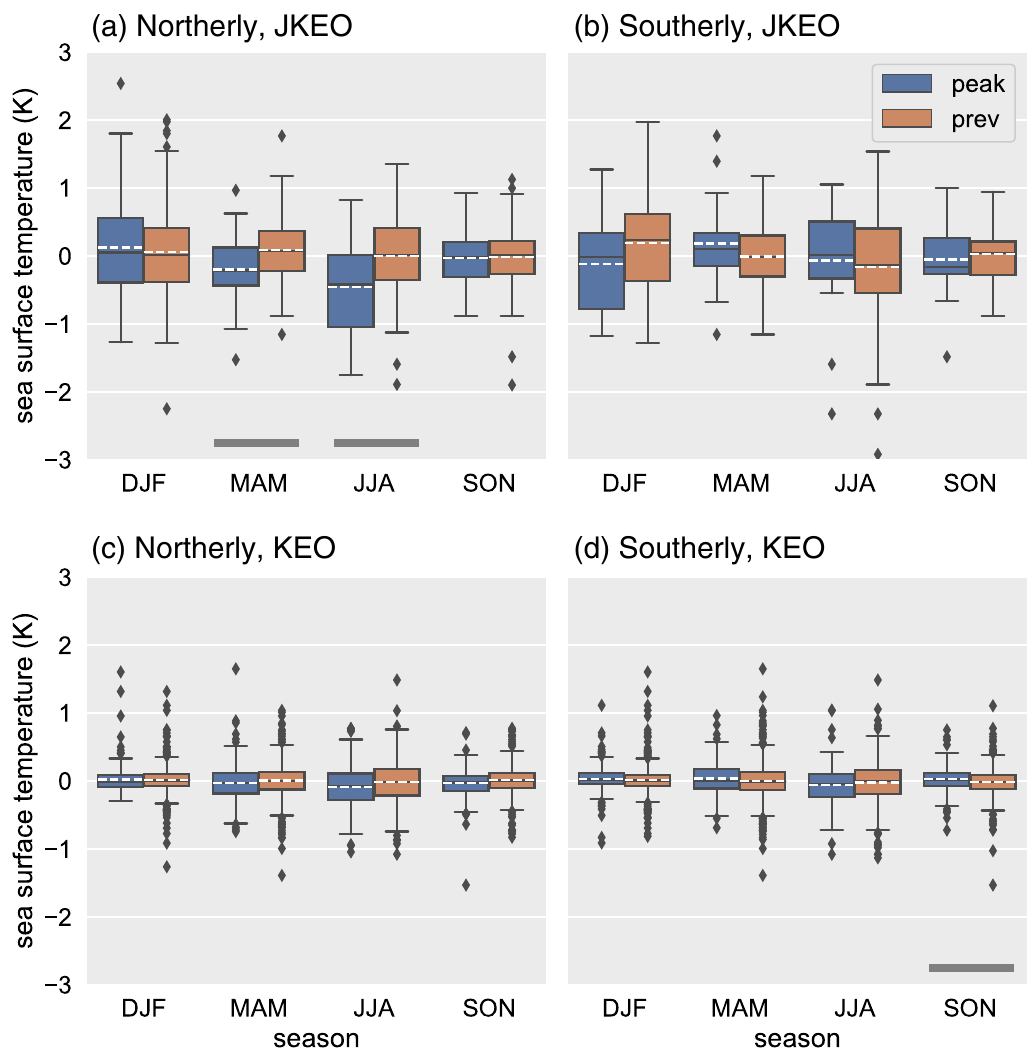
Figure 8. Seasonality of the sea surface temperature response to the ( a , c ) northerly and ( b , d ) southerly wind events. Significant differences (95%) are indicated as thick black bars at the bottom. Other configurations are same as Fig.